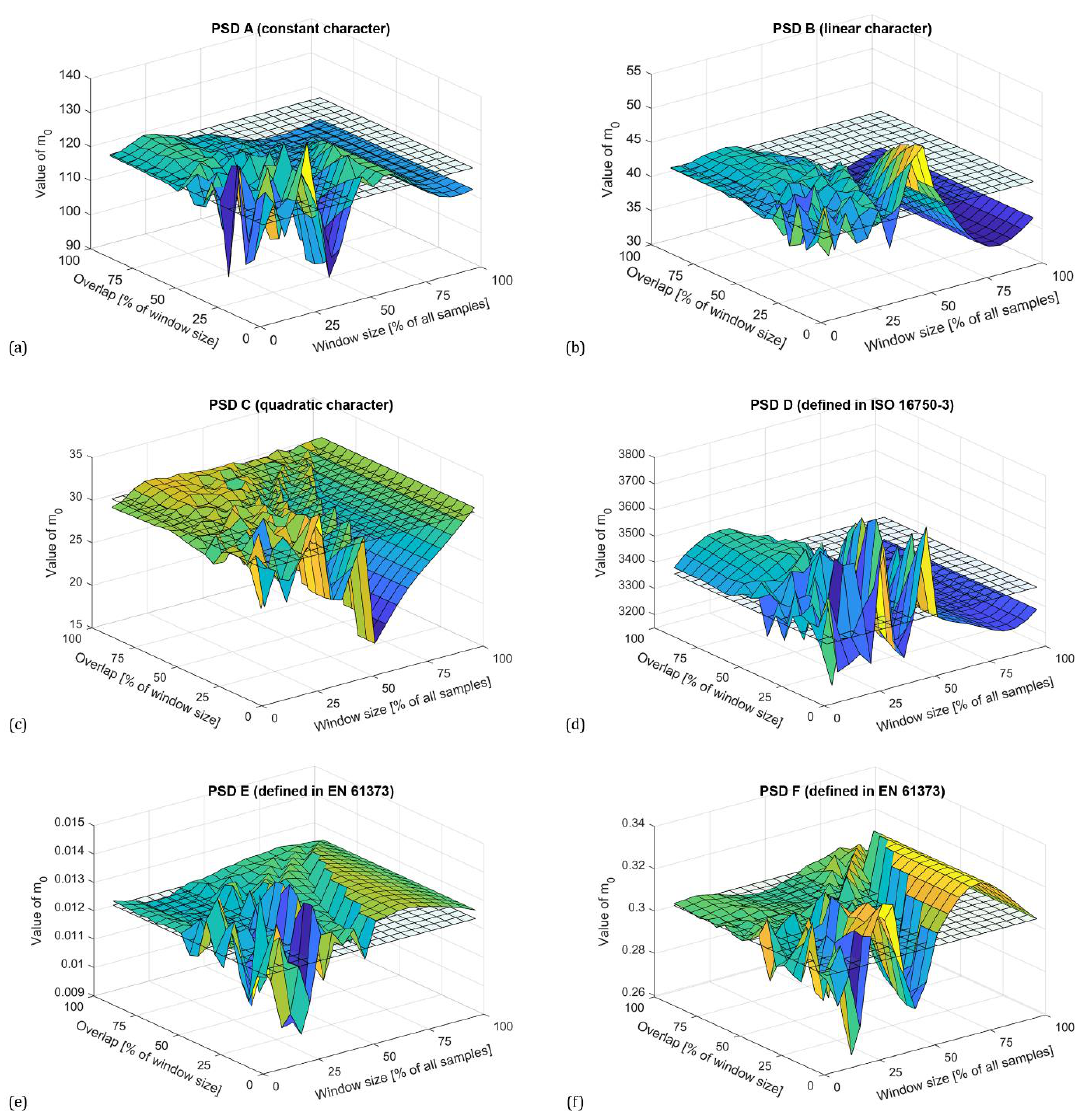
Figure 6. Zero spectral moments (variance) depending on window size and overlap for all PSDs computed using Hanning window according to synthesized PSD using constants (a), constants with linear connection (b), and constants with quadratic connection (c), standardized PSD functions according to ISO 16750-3 (d) and EN 61373 (e)-(f).